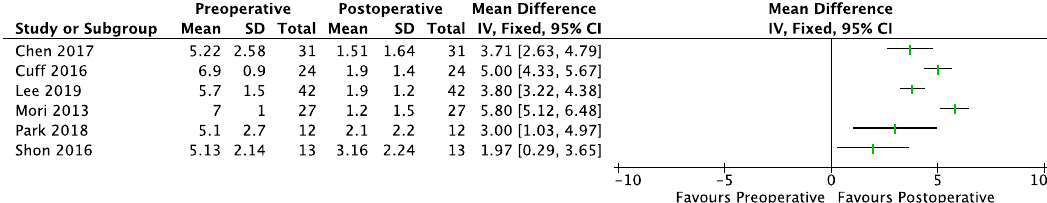
Figure 4. Forest plot of comparison: VAS, outcome in PCR ‐ BT. SD: Standard Deviation.